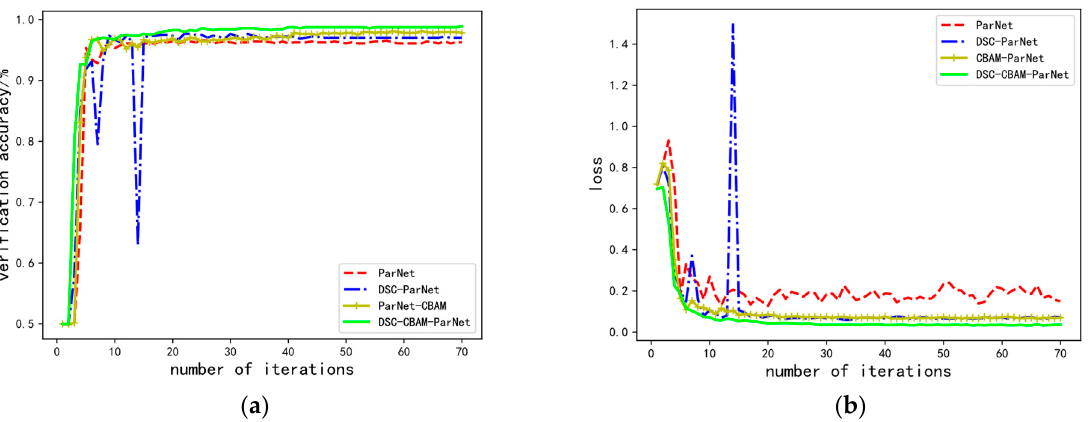
Figure 11. Verification accuracy and loss curves of ablation experiment. ( a ) verification accuracy; ( b ) verification loss. ( b ) verification loss.